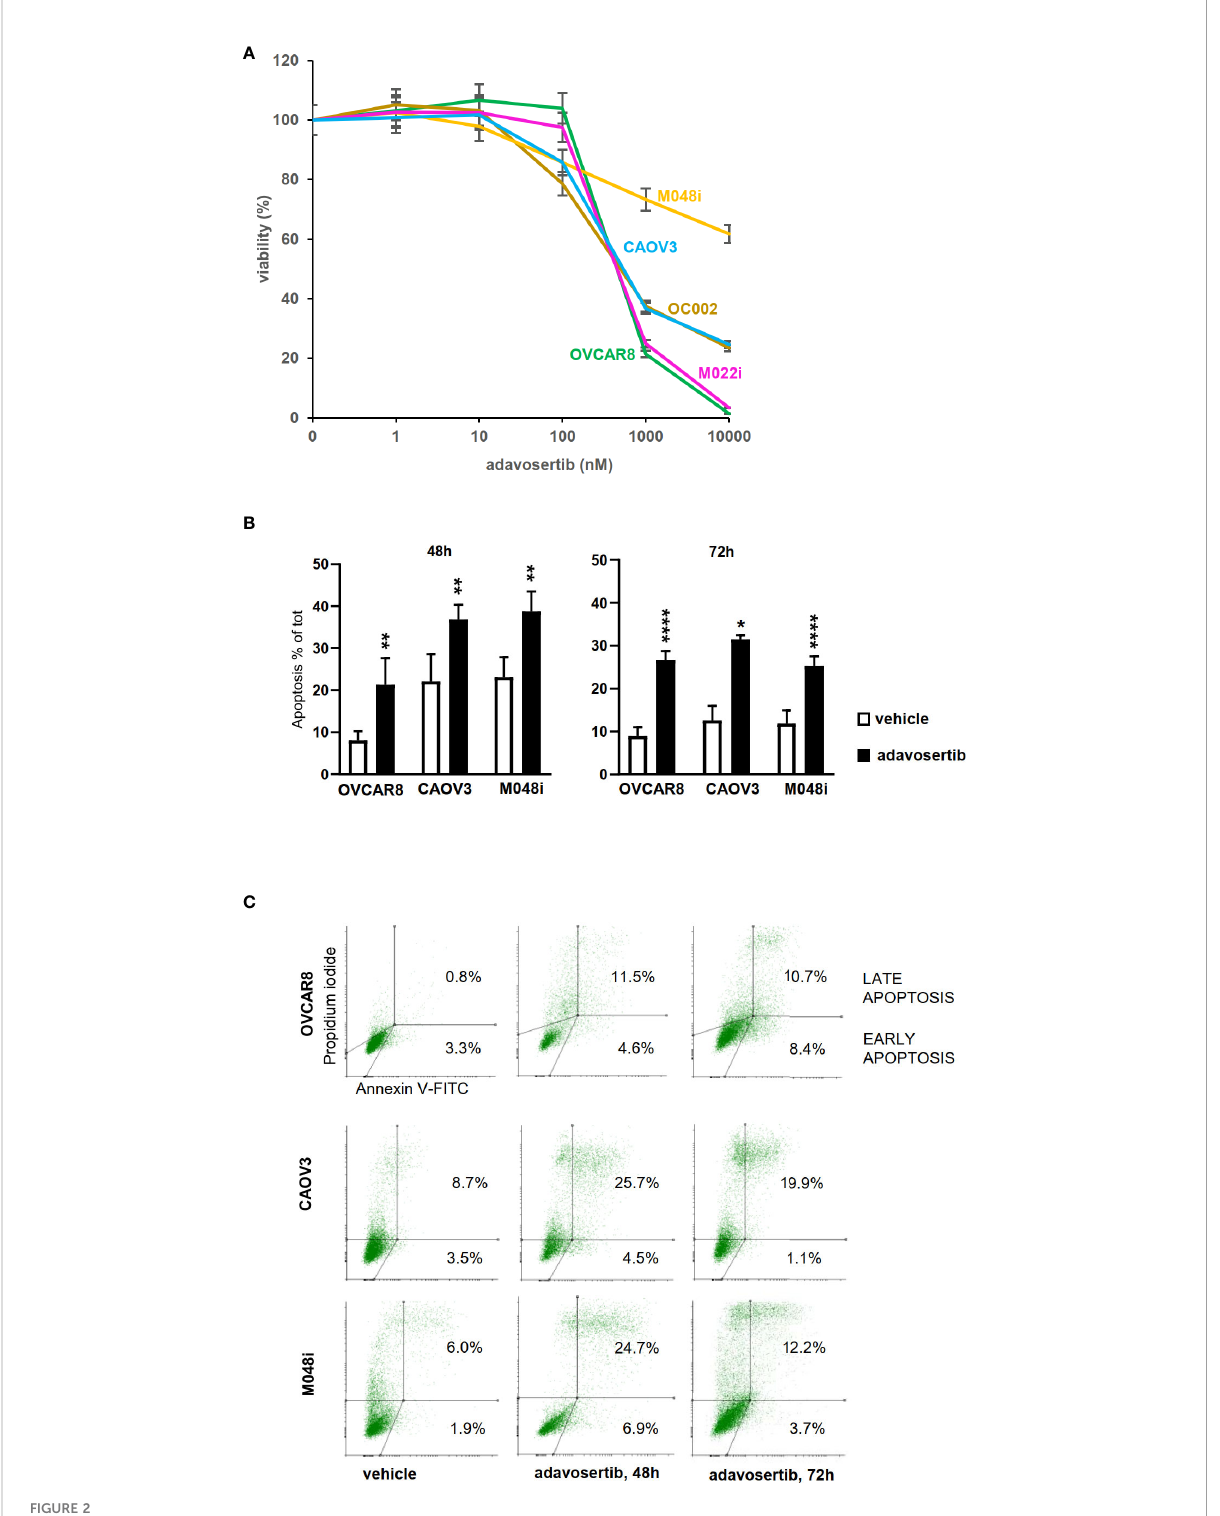
FIGURE 2 Effects of adavosertib on cell viability and apoptosis. (A) Viability was assessed after a 72-h treatment with adavosertib in fi ve different concentrations (1 – 10,000 nM) (±SD). (B) Apoptosis was measured in three HGSOC cell lines (OVCAR8, CAOV3, and M048i) with annexin V staining detected by fl ow cytometry. Apoptotic cell populations (% of total cell amount, ±SD) were signi fi cantly elevated in all cell lines after 48 and 72 h of treatment with 500 nM adavosertib as compared with the control cells (p-value: ns = p > 0.05, *p ≤ 0.05, **p ≤ 0.01, and ****p ≤ 0.0001). (C) Distribution of early and late apoptotic cell populations (% of total number of